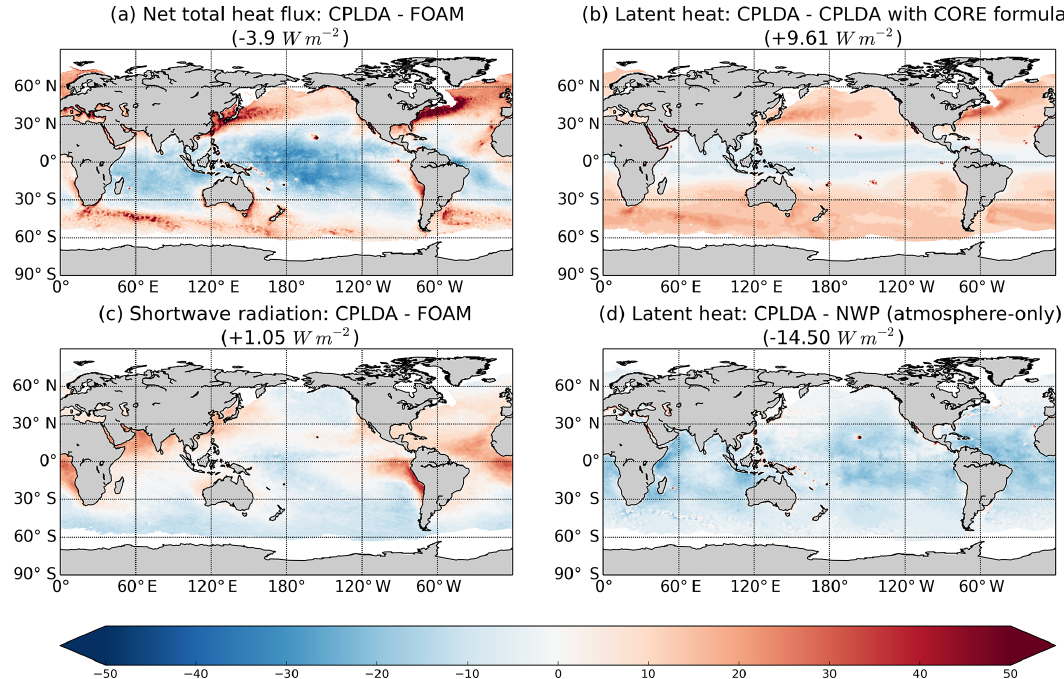
Figure 9. Annual mean net downward heat flux differences (Wm − 2 ): (a) total heat flux difference between CPLDA and FOAM ( − 3 . 9Wm − 2 ), (b) latent heat flux difference caused by using COARE3.0 bulk formulae in CPLDA rather than CORE as in FOAM ( + 9 . 61Wm − 2 ), (c) shortwave radiation difference between CPLDA and FOAM ( + 1 . 05Wm − 2 ), and (d) latent heat difference between CPLDA and the atmosphere-only NWP system, both of which are using COARE3.0 bulk formulae ( − 14 . 5Wm − 2 ). In brackets are the average values for the global